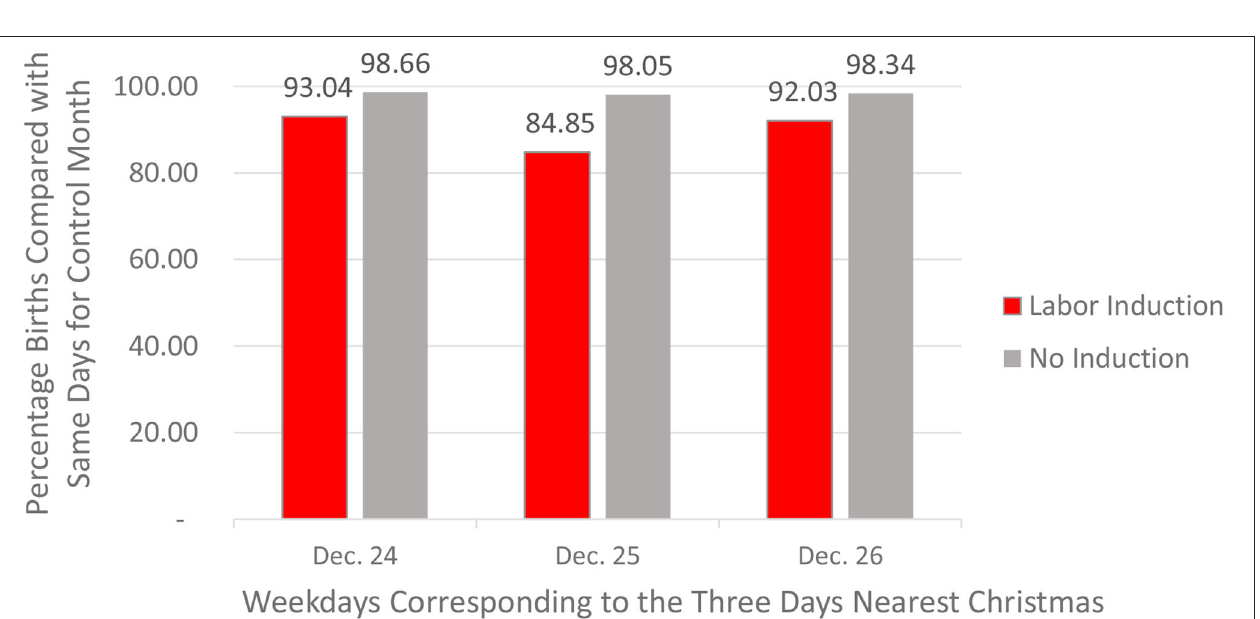
FIGURE 9 | December 2016 birth deficits (compared with same days in control month) for induced and non-induced vaginal births on the days of the week corresponding to December 24, 25, and 26 (CDC Data).